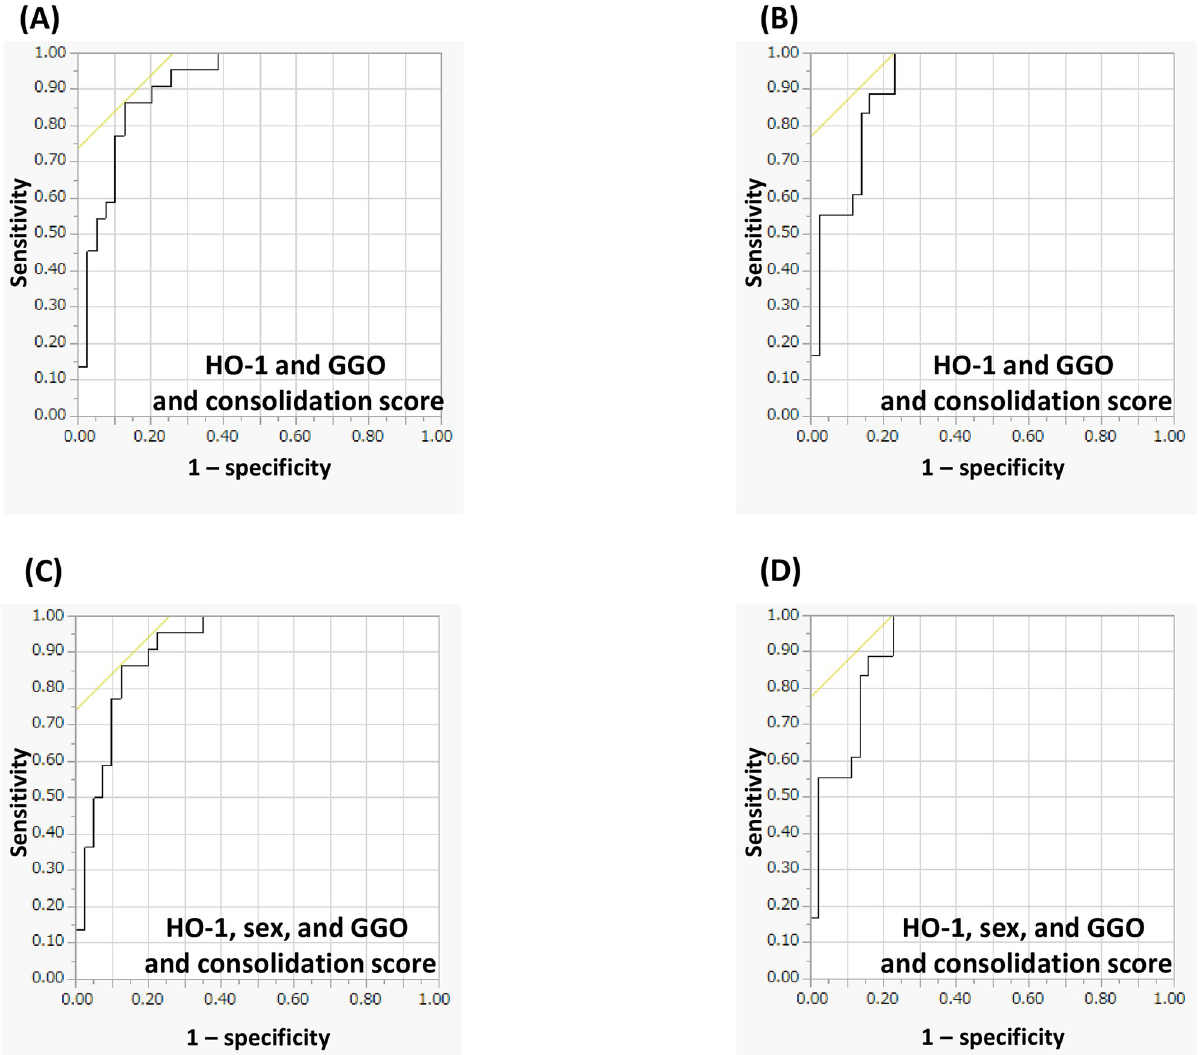
Fig 3. Prediction of treatment outcomes using the combination of serum heme oxygenase (HO)-1 and ground glass opacity (GGO) and consolidation score. (A) Serum HO-1 and GGO and consolidation score for predicting intensive care unit (ICU) admission: the area under the receiver operating characteristic curve (AUC): 0.915 (P < 0.001); (B) Serum HO-1 and GGO and consolidation score for predicting mechanical ventilation: AUC 0.919 (P < 0.001); (C) Serum HO-1, sex, and GGO and consolidation score for predicting ICU admission: AUC 0.916 (P < 0.001); (D) Serum HO-1, sex, and GGO and consolidation score for predicting mechanical ventilation: AUC 0.920 (P < 0.001). (A, C) Analysis of the prediction of ICU admission and mechanical ventilation support using composite parameters including serum HO-1, sex, and the GGO and consolidation score show that the combination has a higher the AUC than the AUCs of a single predictor (only HO-1) or the combination of two (serum HO-1 and GGO and consolidation score). (B, D) The composite parameters including serum HO-1, sex, and the GGO and consolidation score calculated for prediction of mechanical ventilation support shows a higher AUC than AUCs of a single predictor or a combination of two.